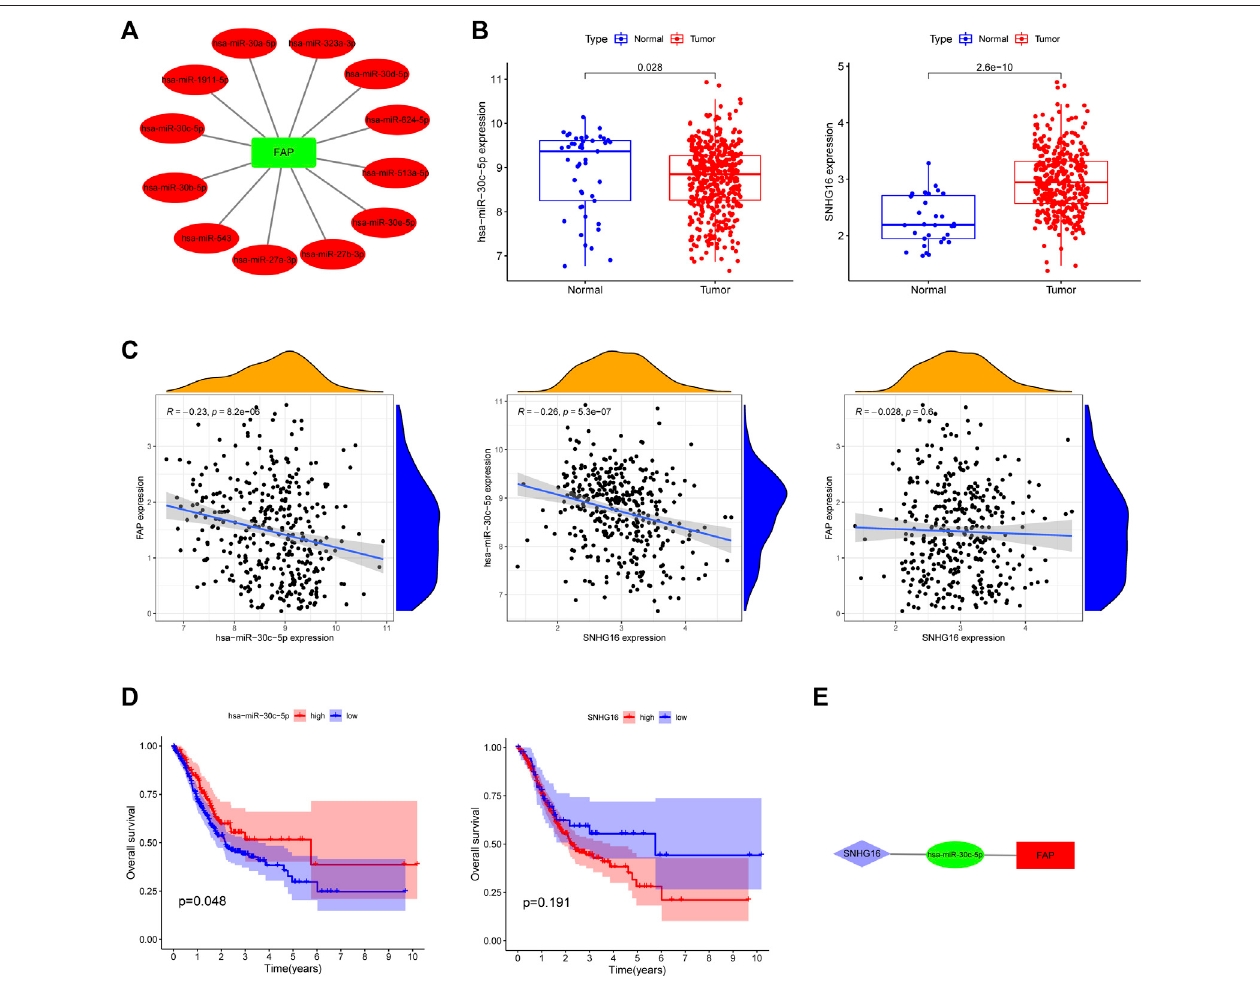
FIGURE 4 | Identi fi cation of a FAP regulatory network. (A) A correlation network between FAP and miRNAs. (B) Expression of hsa-miR-30c-5p and SNHG16 in TCGA. (C) Association between FAP, SNHG16 and hsa-miR-30c-5p evaluated using the TCGA database. (D) Overall survival of hsa-miR-30c-5p and SNHG16 assessed using Kaplan – Meier Plotter. (E) A triple regulatory network in